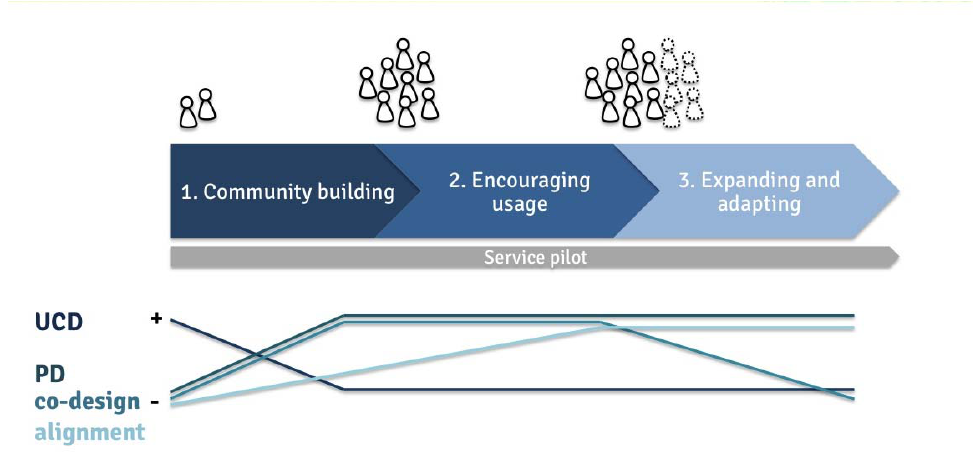
Figure 3 . The pilot phases and the main methods